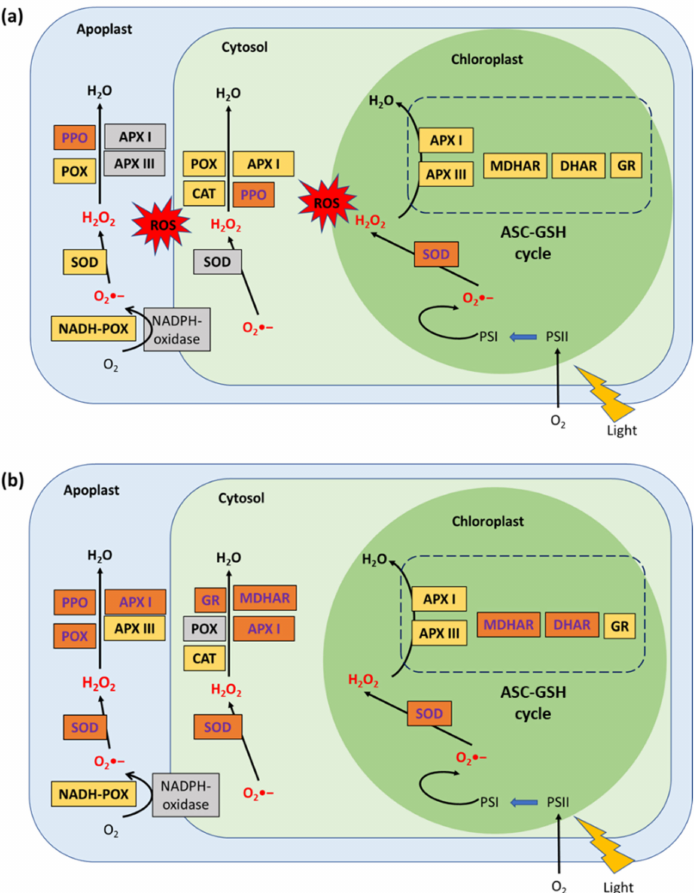
Figure 4. Differences in the antioxidant system between susceptible and resistant apricot cultivars. ( a ) Changes in the antioxidant system in susceptible apricot cultivars. ( b ) Changes in the antioxidant system in resistant apricot cultivars. The orange color indicates an increase of the enzymatic activity, and the yellow color indicates a decrease in the enzyme activity. The grey color indicates no changes in the enzyme activity. PPO: Polyphenol oxidase; APX I: class I Ascorbate peroxidase; APX III: class III Ascorbate peroxidase; SOD: Superoxide dismutase; POX: Peroxidase; CAT: Catalase;